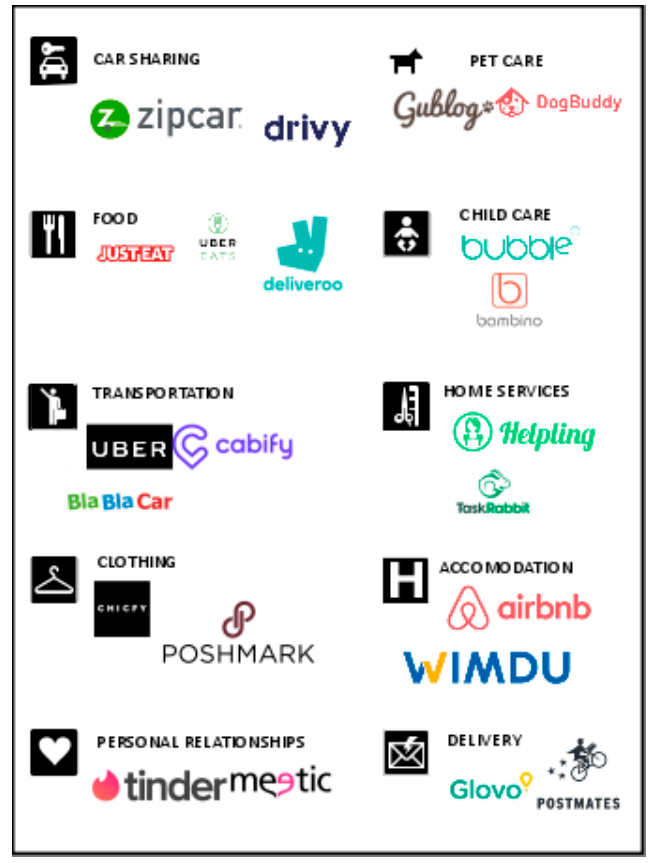
Figure 2. Some examples of digital platforms offering a wide range of services.